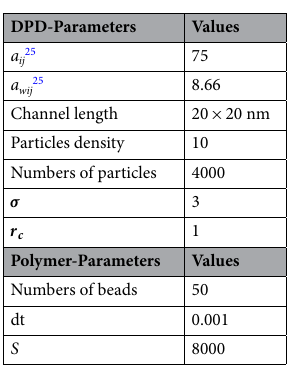
Table 1. DPD and polymer constant